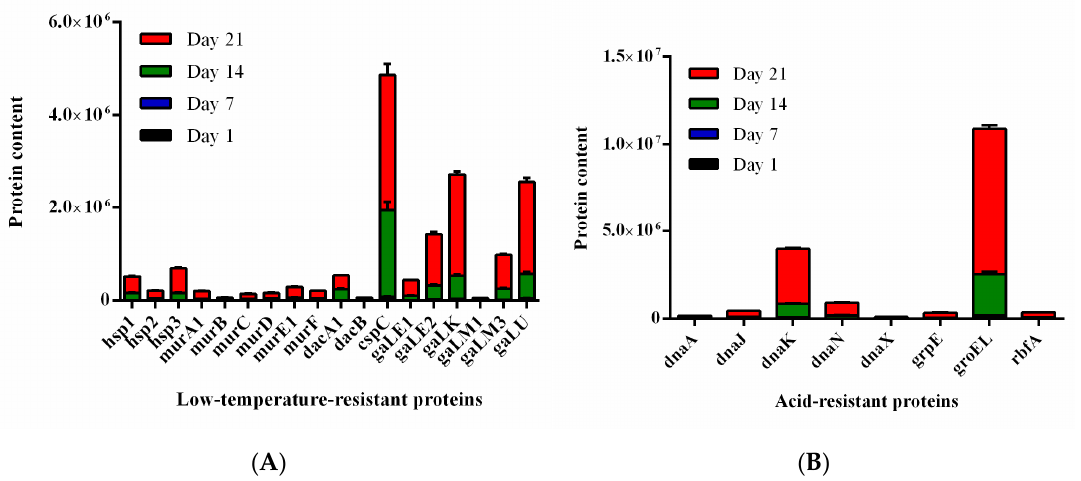
Figure 7. Expression of low-temperature-resistant proteins ( A ) and acid-resistant proteins ( B ) during cold storage of Lpb. plantarum NMGL2 fermented milk at days 1, 7, 14, and 21.